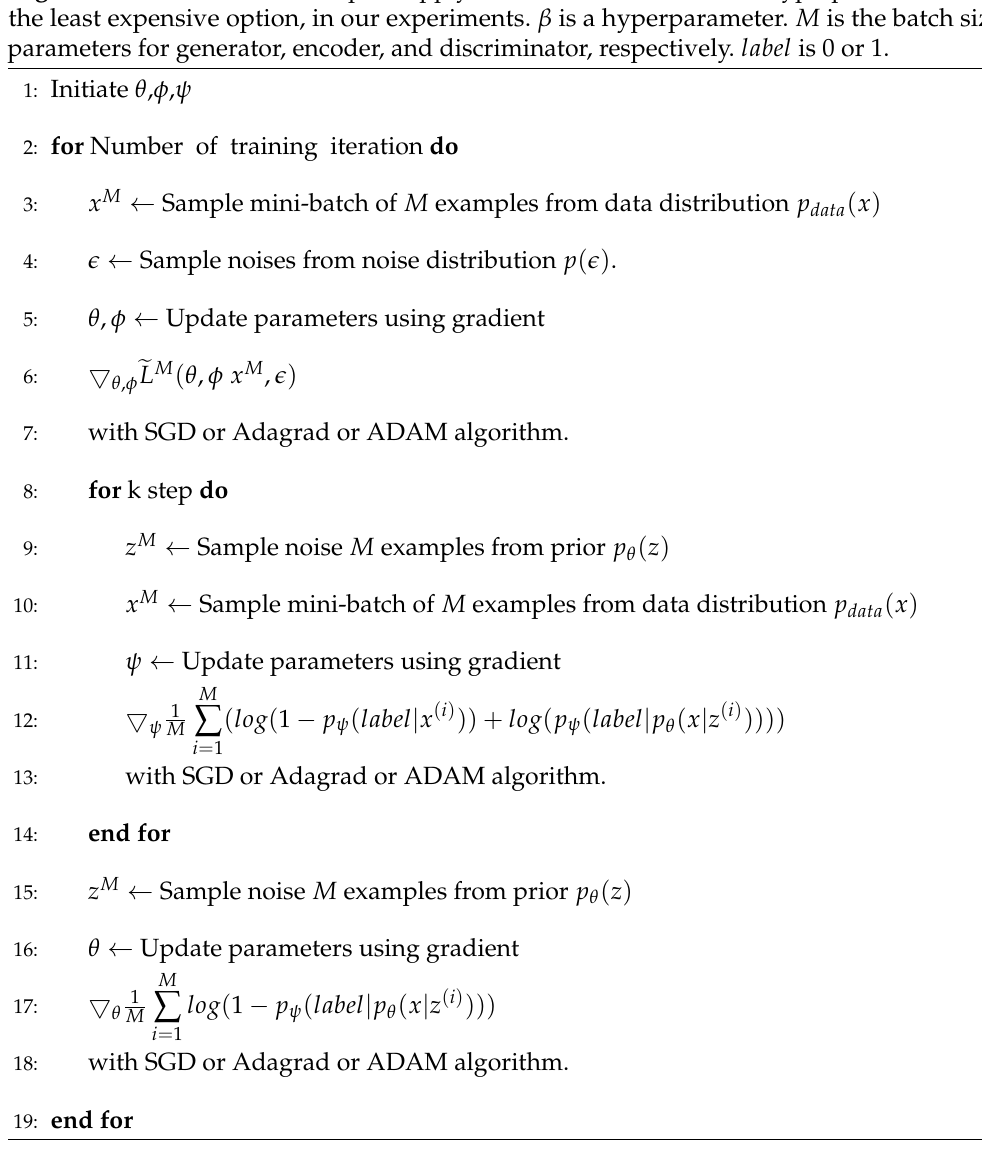
Algorithm 1 The number of steps to apply to the discriminator, k , is a hyperparameter. We used k = 1, the least expensive option, in our experiments. β is a hyperparameter. M is the batch size. θ , φ , ψ are parameters for generator, encoder, and discriminator, respectively. label is 0 or